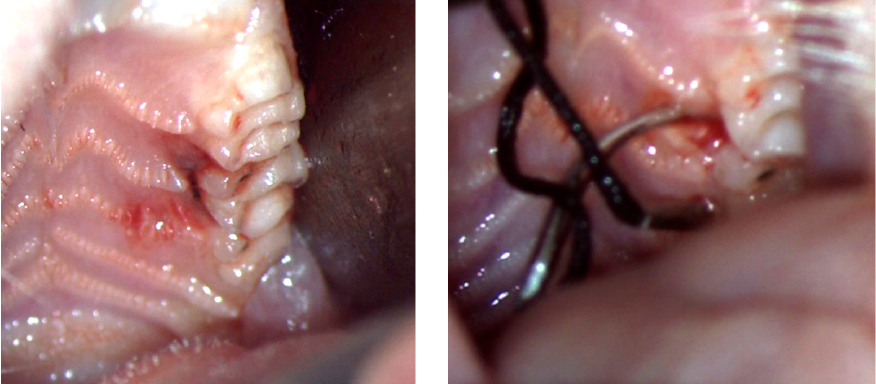
Figure 1. Ligature application around molars.